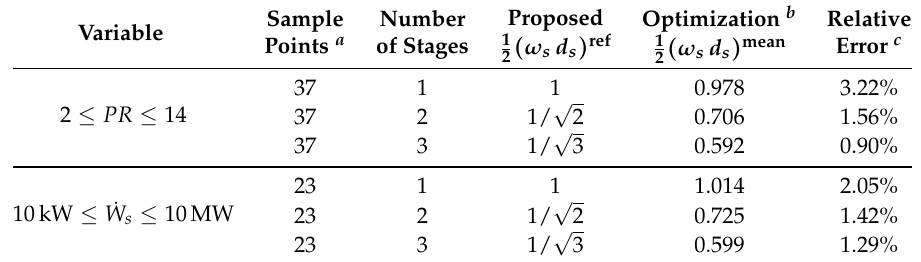
Table 5. Comparison of the suggested optimal specific blade speed with the optimization results. Proposed Sample Number Relative Optimization b Variable 1 1 ( ω s d s ) ref ( ω s d s ) mean Points a of Stages Error c 2 2 37 1 1 0.978 3.22% √ 2 ≤ PR ≤ 14 37 2 1/ 2 0.706 1.56% √ 3 0.592 0.90% 37 3 1/ 23 1 1 1.014 2.05% √ 10kW ≤ ˙ W s ≤ 10MW 23 2 1/ 2 0.725 1.42% √ 23 3 1/ 3 0.599 1.29% ∑ i = N a Number of points ( N ) used to sample the PR and ˙ W b Computed according to 1 ( ω s d s ) i s intervals. i = 1 2 N where the index i = 1,2,. . ., N corresponds to each of the sample points. c Computed according to 1 ( ω s d s )